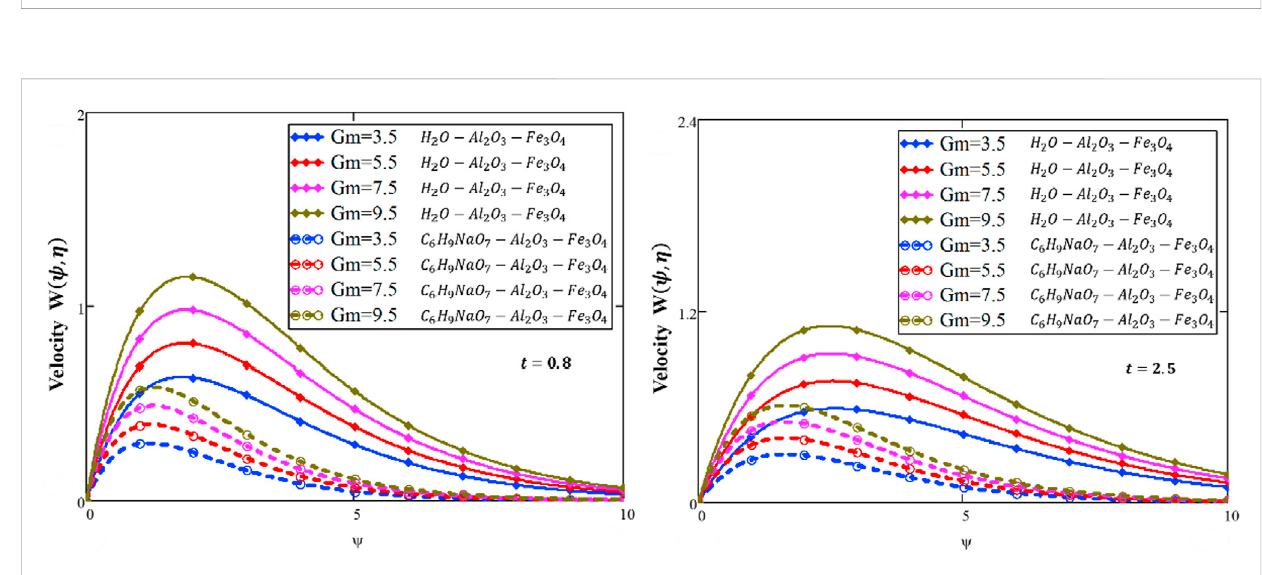
FIGURE 9 Simulation to explain the velocity for changing Gm when α (cid:3) 0 . 4 , Pr (cid:3) 3 . 2 , ϕ 1 (cid:3) ϕ 2 (cid:3) 0 . 3 , Gr (cid:3) 8 , Sc (cid:3) 0 . 2 , λ 1 (cid:3) 1 . 2 , and λ 1 (cid:3) 0 . 3.